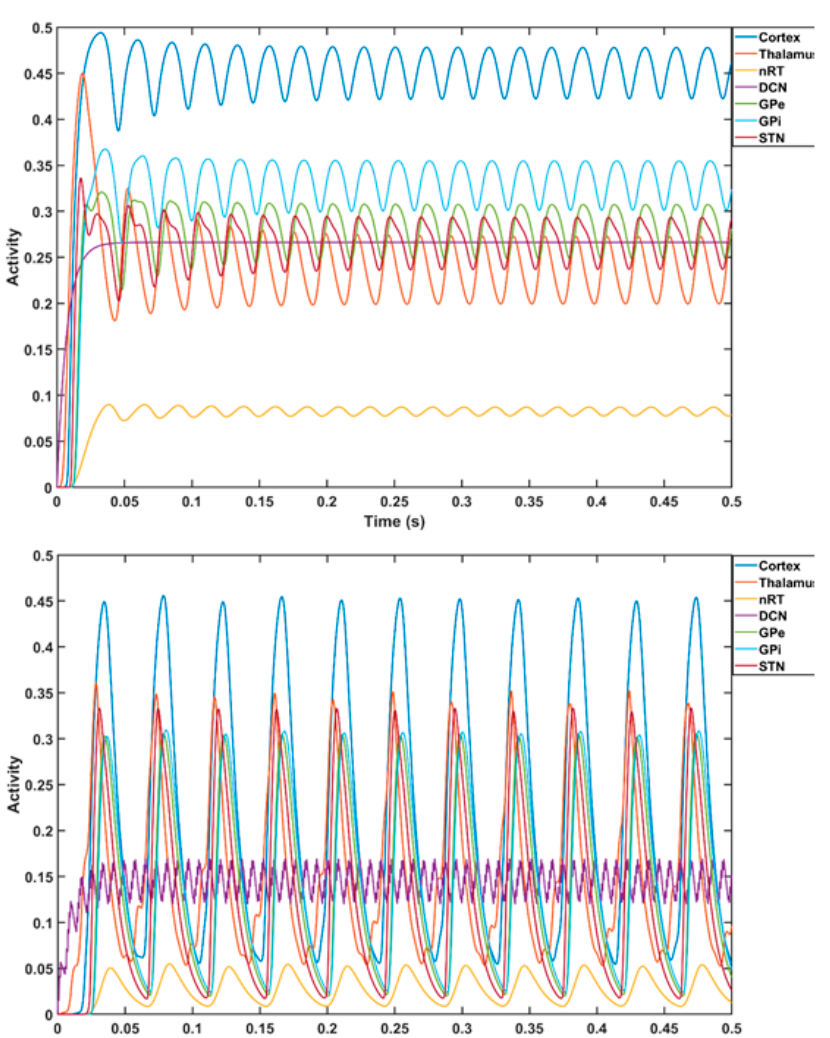
Figure 6. Computational modeling of thalamocortical basal ganglia with the cerebellum [104]. Top plot shows the cortical gamma frequency oscillations (in dark blue color) with a constant external input (transcranial direct current stimulation) to the deep cerebellar nuclei. The top plot also shows the oscillations in other components of thalamocortical basal ganglia model with the cerebellum – the excitatory ventralis intermedius (Vim) nucleus and the inhibitory reticular nucleus (nRT), an excitatory population of the deep cerebellar nuclei (DCN), an excitatory population representing the subthalamic nucleus (STN), and two inhibitory populations representing the external part of the globus pallidus (GPe) and the internal part of the globus pallidus (GPi). Bottom plot shows the transition of the cortical oscillations to beta frequency with tTIS of DCN at a 63 Hz.